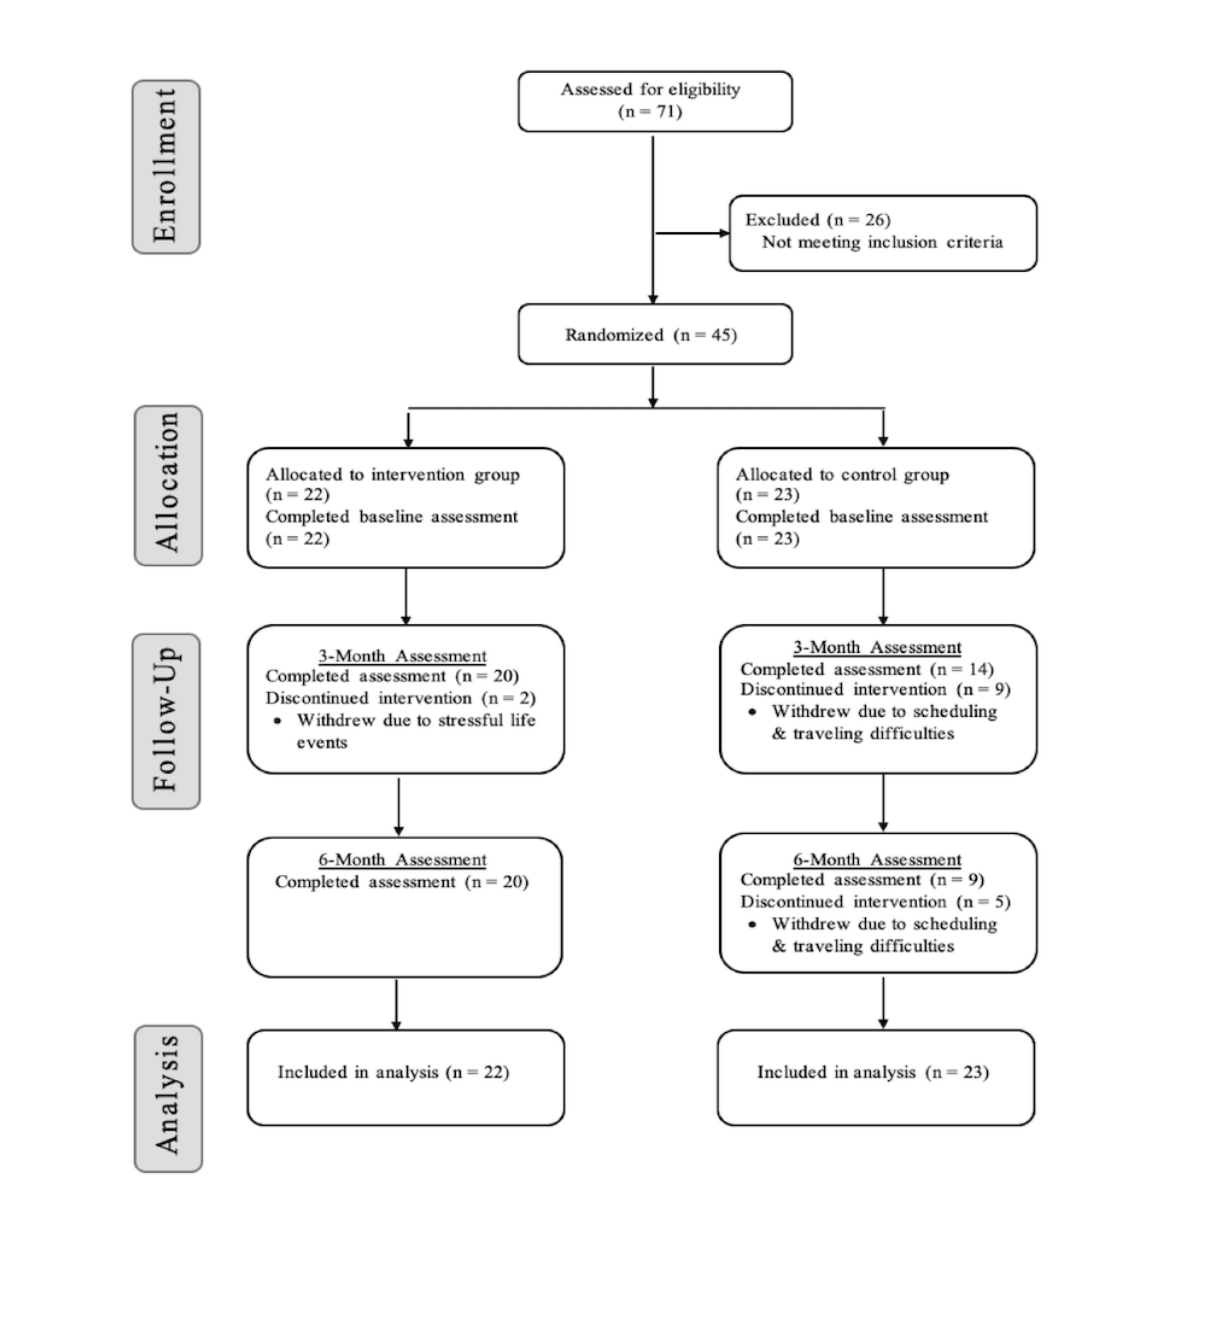
Figure 1. Consort flow